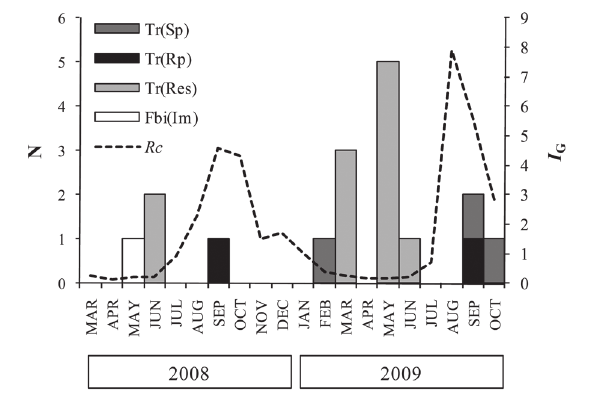
Fig. 5. Monthly distribution of number (N) of females of Alphestes afer in sex change during reproductive cycle (from March 2008 up to October 2009); I Fbi (Im), inactive bisexual phase of female; Tr(Re), transitional phase of resting; Tr(Rp), transitional phase of ripe; Tr(Sp), transitional phase of spent female; Rc , reproductive cycle (n= 17).